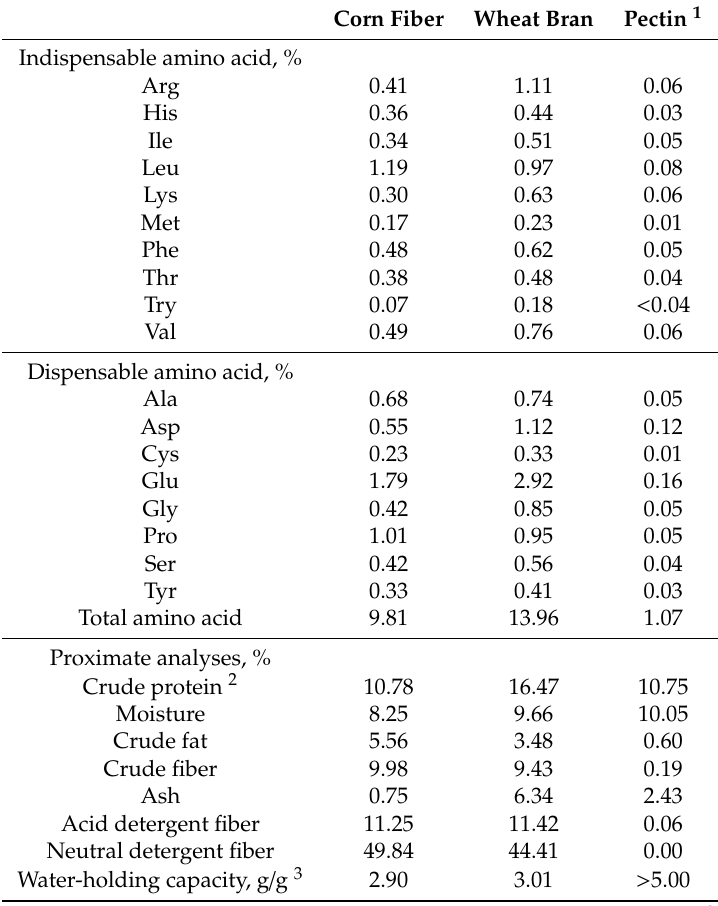
Table 1. Analyzed amino acid contents and proximate analysis of corn fiber, wheat bran, and pectin. Corn Fiber Wheat Bran Pectin 1 Indispensable amino acid,